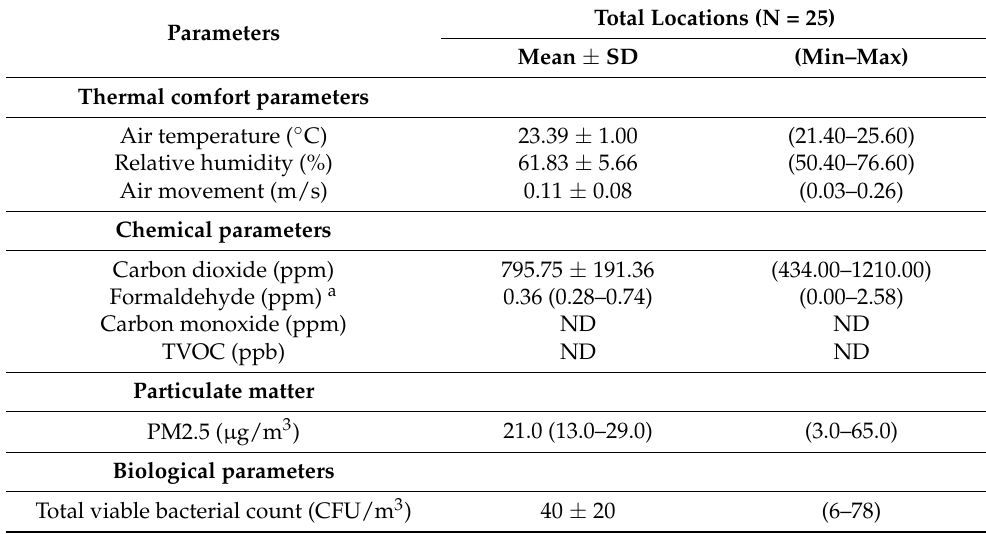
Table 2. Indoor air-quality parameters of participants’ working